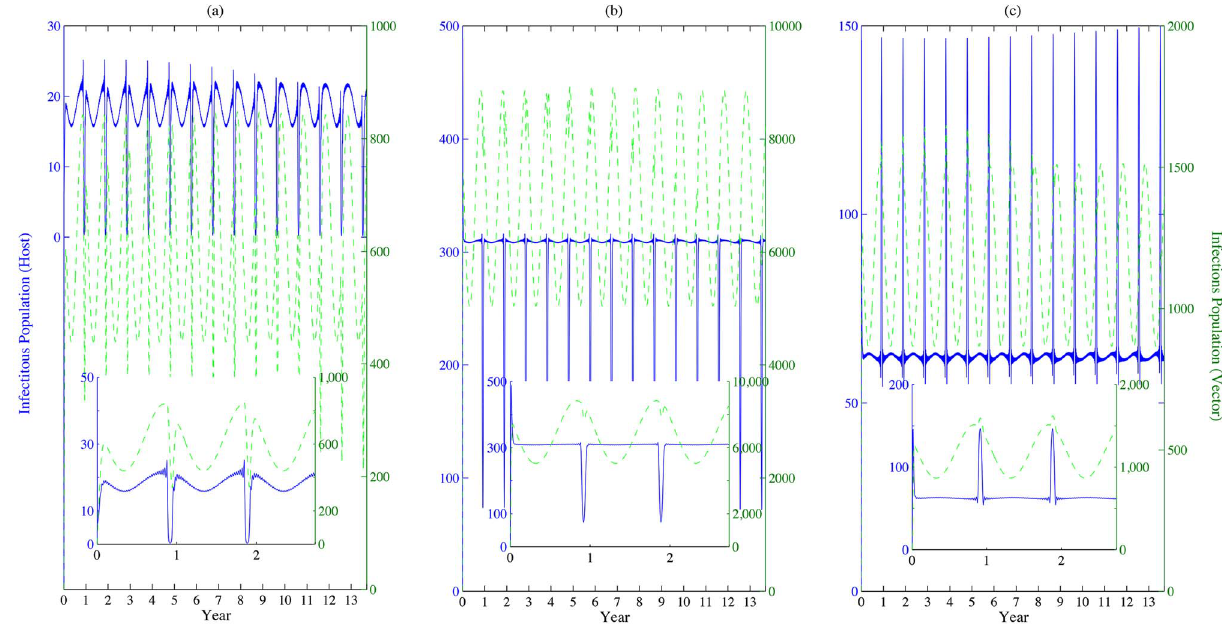
Fig. 4. Populations of infected livestock and mosquitoes. (a), (b) and (c) represent the populations of infectious livestock (solid line) and vectors (dashed line) in patches 1, 2 and 3, respectively. Same values of parameters are adopted in Fig. 3. Populations of both infected livestock and mosquitoes alter their patterns during the festival time. Due to the effect of increased movement rates during the festival, the peak of infected livestock population is not necessary to be the same as that of the infected mosquito population, i.e. patch 2.